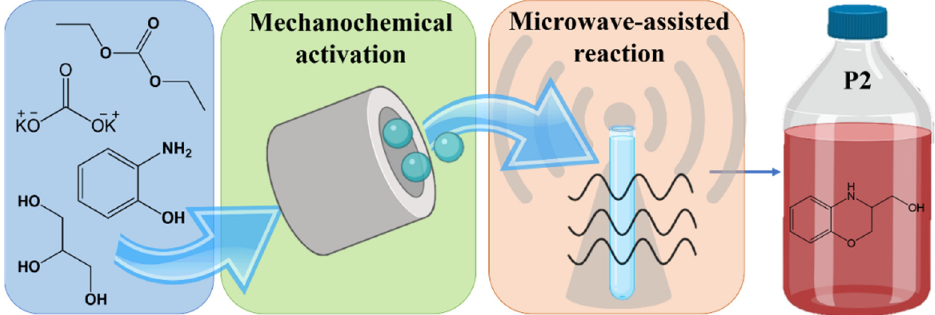
Figure 1. Illustrative representation of the reaction of 2-aminophenol with glycerol through a com- bined mechanochemical and microwave-assisted approach.